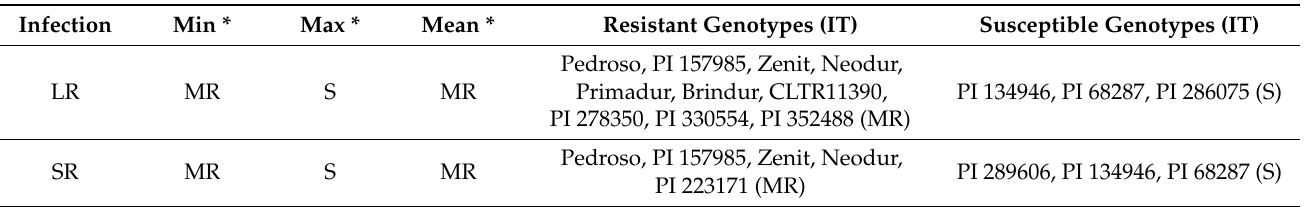
Table 5. Descriptive statistics of the mean APR to LR and SR evaluated at Karabalyk agricultural experimental station in 2017 and 2018.